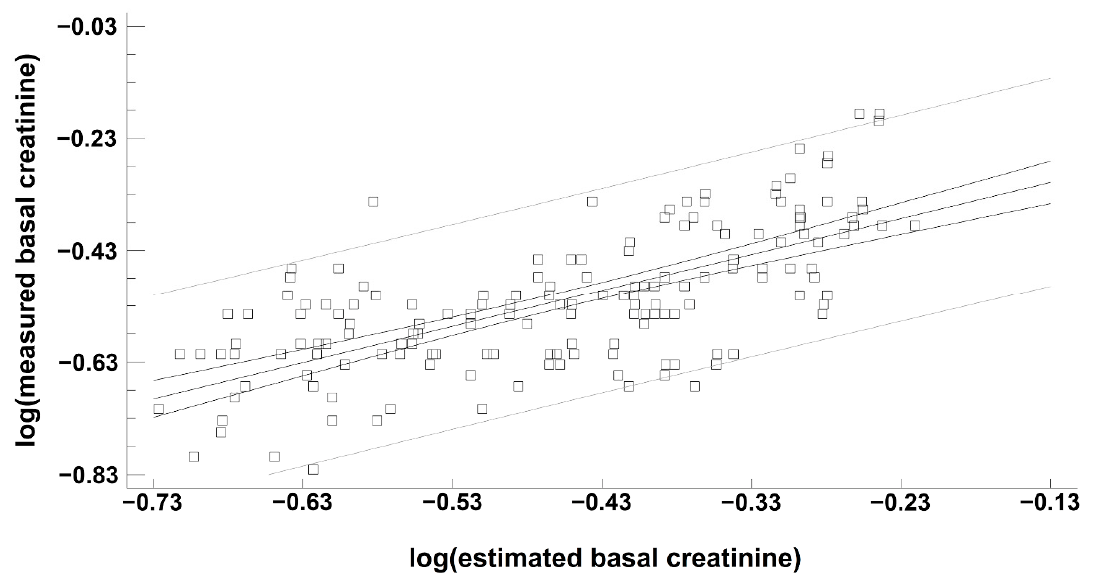
Figure 2. Regression analysis describing the relationship between measured baseline creatinine (mbSCr) and height-estimated baseline creatinine (ebSCr). Model r 2 = 46.6 percent; p < 0.001; correlation coefficient = 0.68. The regression is described by the equation y = − 0.224701 + 0.645172x. p value for intercepts was <0.001, p value for the slopes was <0.001. Spearman test: rho = 0.67, p < 0.001.